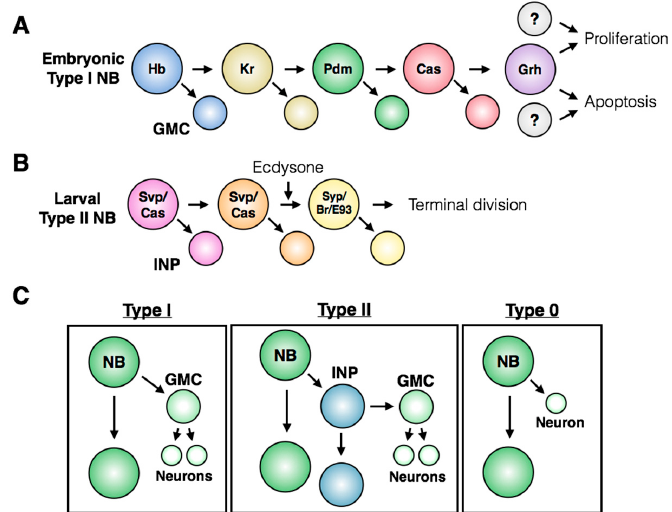
Figure 4. The temporal series and division patterns of Drosophila neuroblasts. ( A ) The temporal transcription factor (TTF) sequence expressed in embryonic Type I neuroblasts. The last member, grainyhead , has been shown to regulate both proliferation and apoptosis of neuroblasts, suggesting that context-dependent co-factors may dictate the cell-fate outcome for a given neuroblast. ( B ) The TTF sequence expressed in larval Type II neuroblasts. Progression to the late factors is dependent on the steroid hormone ecdysone, and leads to a terminal division [26,32]. ( C ) Three types of asymmetric neuroblast proliferation patterns observed in the nervous system. Type 0 divisions have only been observed following a period of Type I divisions in embryonic